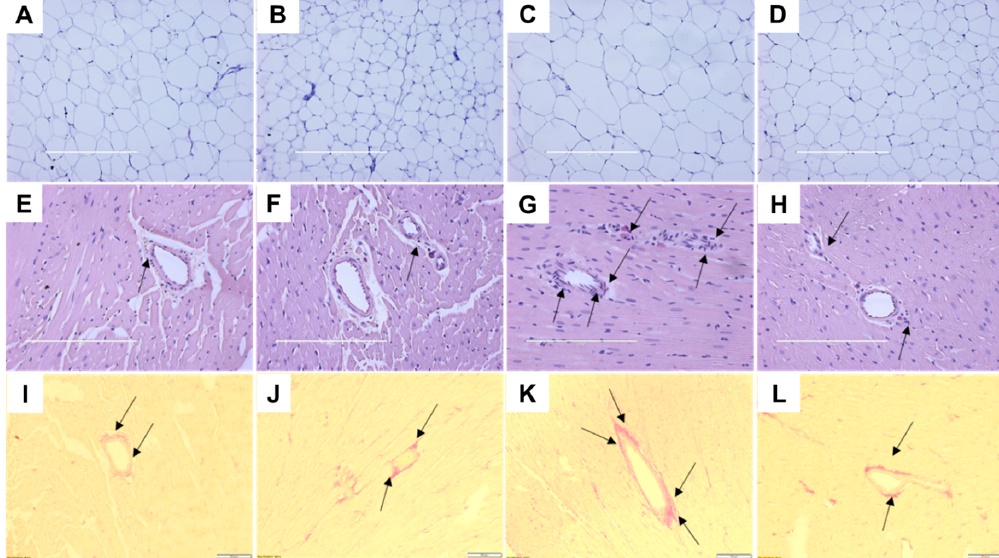
Figure 3. Haematoxylin and eosin staining of adipocytes ( A – D ; magnification × 10; scale bar = 400 µ m); haematoxylin and eosin staining of left ventricle indicating inflammatory cells as dark spots outside myocytes and in vascular endothelium marked as arrow ( E – H ; magnification × 20; scale bar = 200 µ m); and picrosirius red staining of left ventricle indicating collagen deposition as red stain marked by arrows ( I – L ; magnification ×12.6; scale bar = 100 µm). Corn starch diet-fed rats ( A , E , I ), corn starch diet-fed rats treated with Garcinia dulcis rind powder ( B , F , J ), high-carbohydrate, high-fat diet-fed rats ( C , G , K ) and high-carbohydrate, high-fat diet-fed rats treated with Garcinia dulcis rind powder ( D , H , L